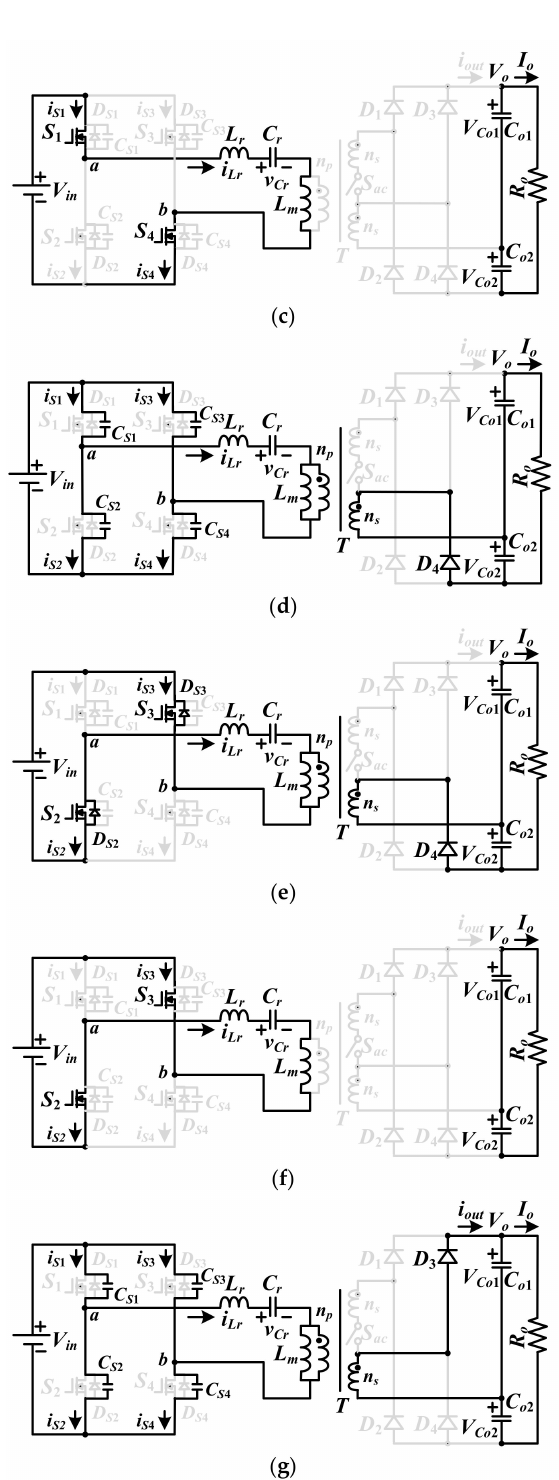
Figure 4. LLC converter at medium input voltage region: ( a ) key PWM waveforms; ( b ) state 1 equivalent circuit; ( c ) state 2 equivalent circuit; ( d ) state 3 equivalent circuit; ( e ) state 4 equivalent circuit; ( f ) state 5 equivalent circuit; ( g ) state 6 equivalent